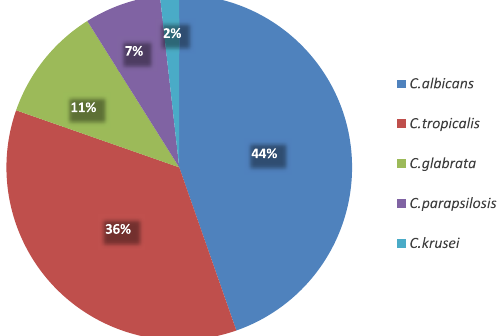
Fig. 1. Percentage wise distribution of various Candida species causing vulvovaginal